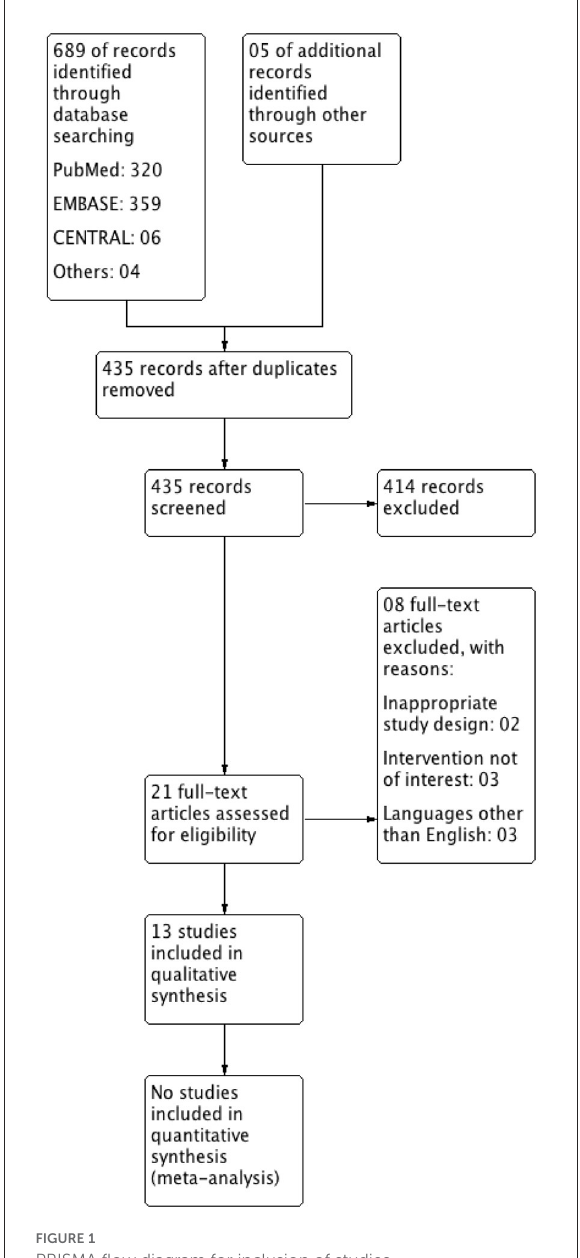
FIGURE1 PRISMA flow diagram for inclusion of studies.